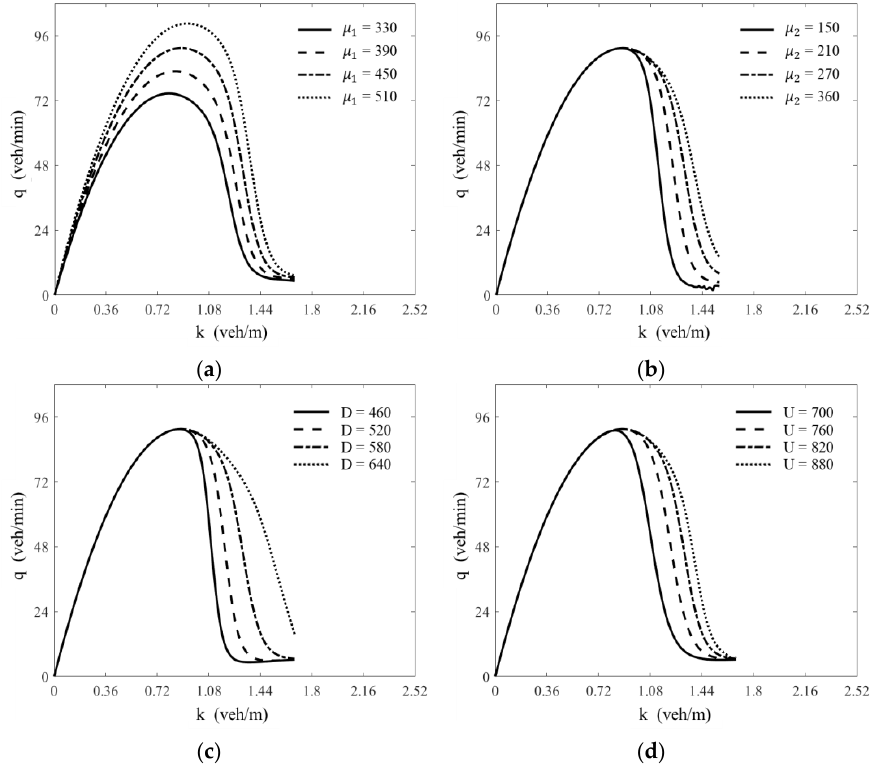
Figure 7. Sensitivity analysis diagram of different parameters. ( a ) is sensitivity analysis of parameter 𝜇 1 ; ( b ) is sensitivity analysis of parameter 𝜇 2 ; ( c ) is sensitivity analysis of parameter 𝐷 ; ( d ) is sensitivity analysis of parameter 𝑈 .